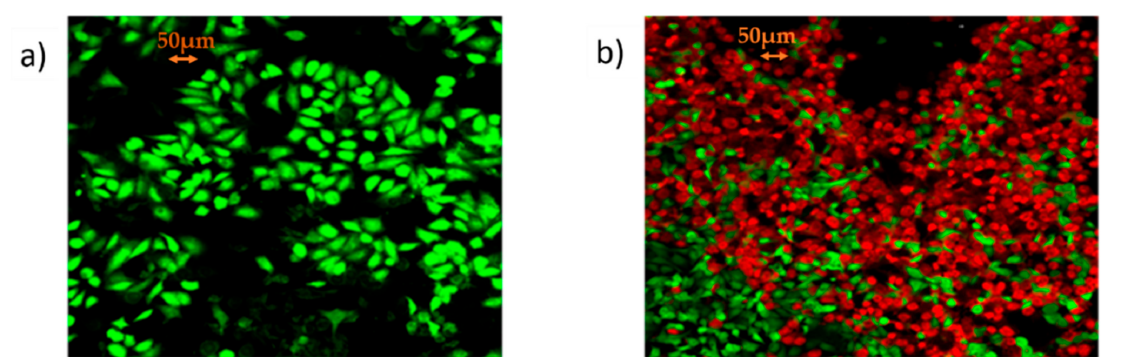
Figure 6. Proof of clinical concept: ( a ) Confocal microcopy microphotograph of MCF7 cells by the live/dead fluorescent staining with Calcein AM/EthD-1; ( b ) confocal microcopy microphotograph by the live/dead fluorescent staining with Calcein AM/EthD-1 showing low levels of cell viability of MCF-7 cells, incubated for 72 h with the supernatant of transfected CHO-K1 with mRNA Trastuzumab (photographs were taken at 10 × magnification; scale bars represent 50 µ